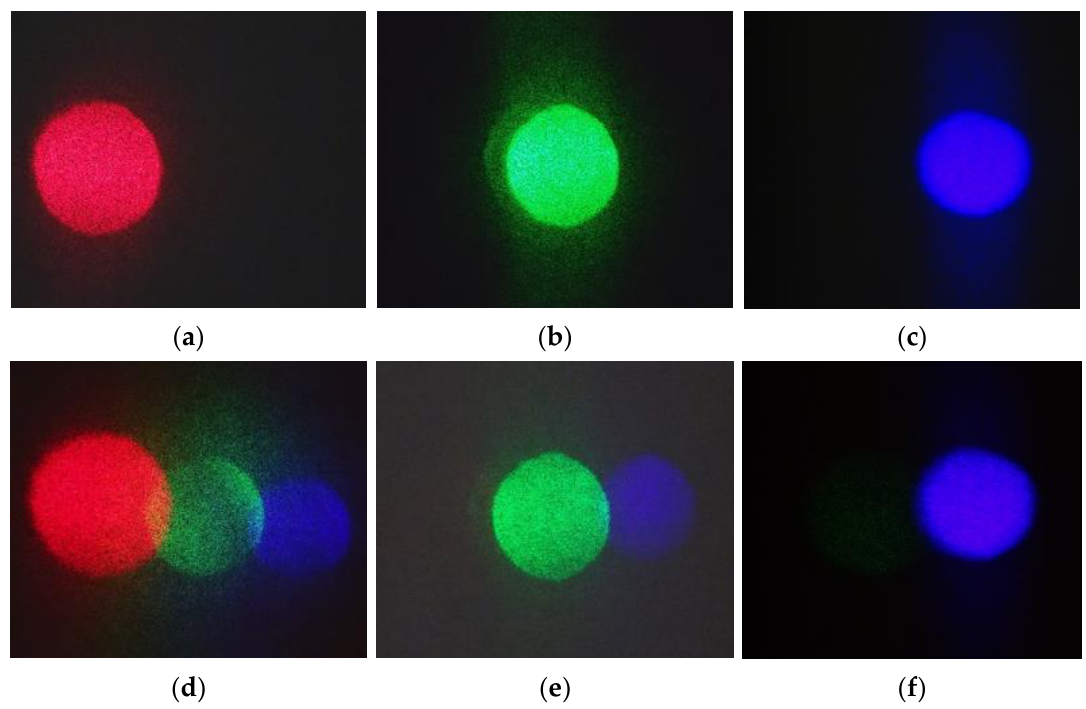
Figure 8. Image of the diffusing object obtained when holograms recorded with each wavelength were illuminated with the recording wavelength: ( a ) 633 nm, ( b ) 532 nm and ( c ) 442 nm, and when each hologram is reconstructed using three lasers simultaneously: ( d – f ).